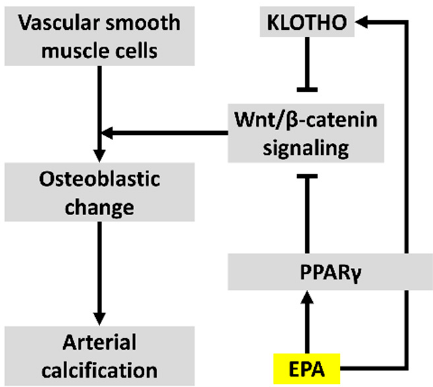
Figure 6. Mechanisms by which EPA suppresses vascular calcification via inhibition of Wnt signaling.